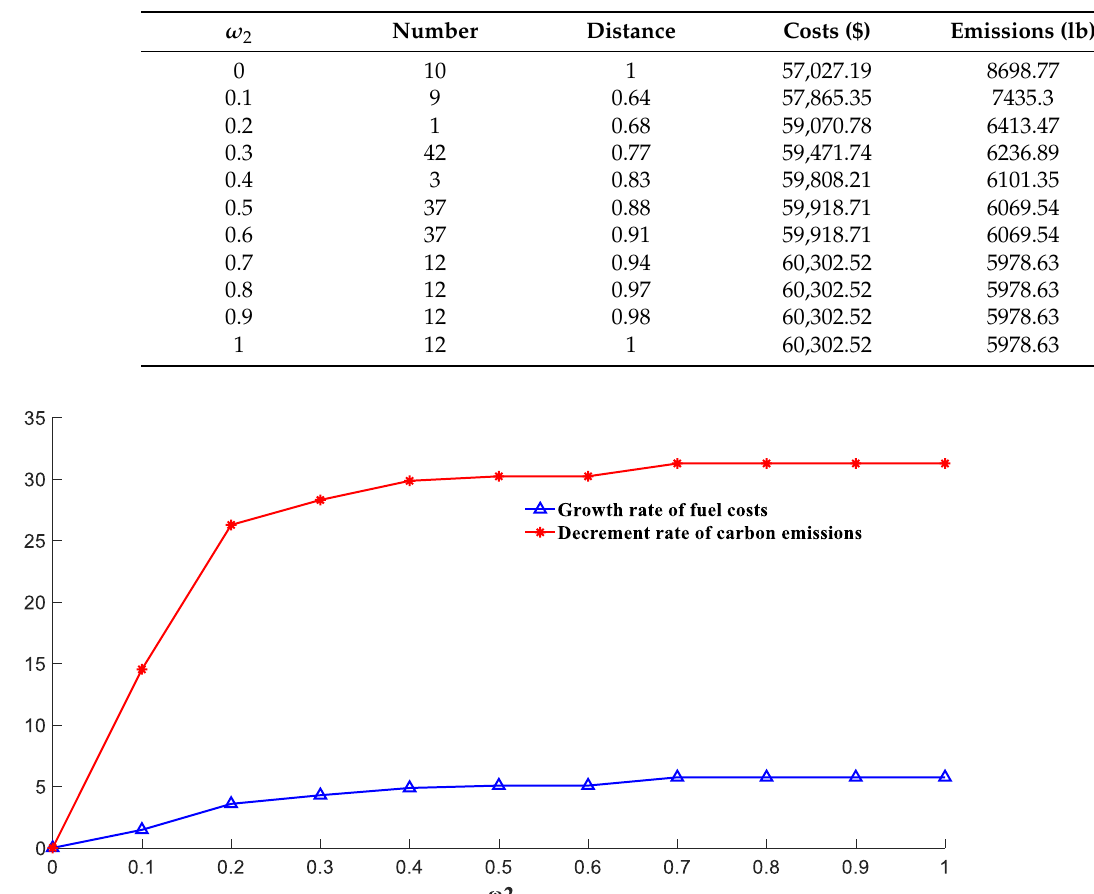
Figure 3. Correlations between